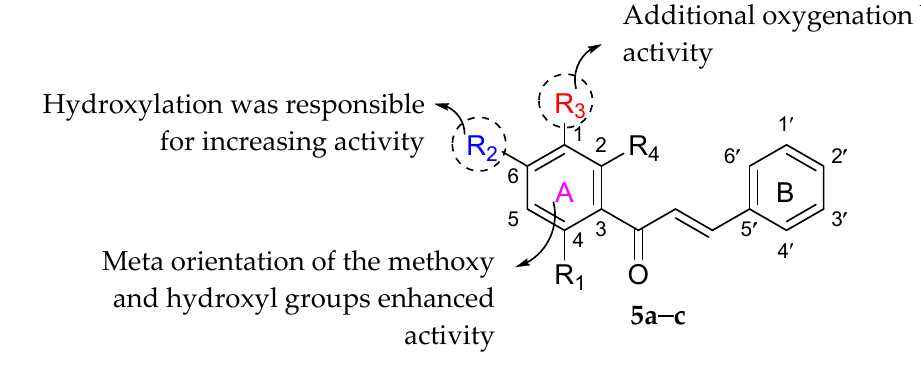
Figure 18. Structural activity of chalcones against MRSA strains [84].